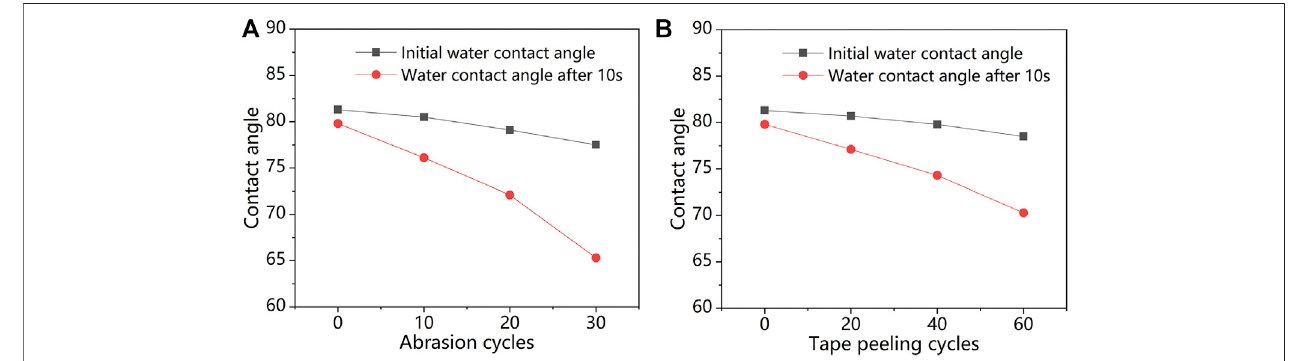
FIGURE6 | Mechanical stability of CW coating. (A) Water contact angle of CW under different abrasion cycles. (B) Water contact angle of CW under different tape peeling cycles.